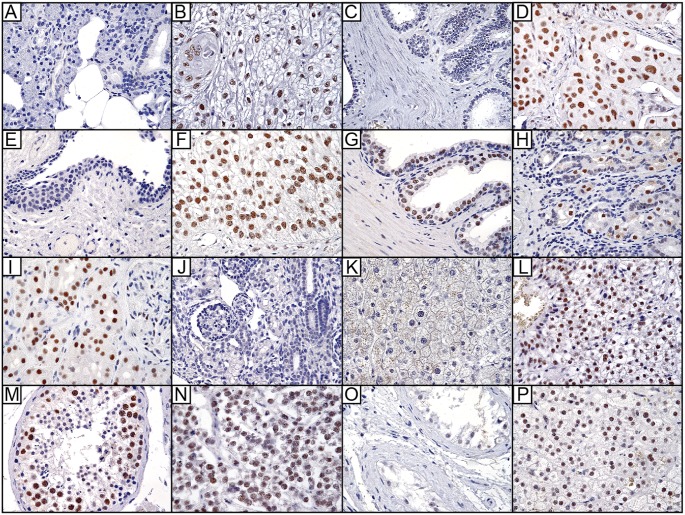
Representative images of MSANTD3 immunostaining in select tissues.(A) Normal salivary tissue, (B) Mucoepidermoid carcinoma, (C) Normal breast tissue, (D) Invasive breast carcinoma, not otherwise specified, (E) Normal bladder, (F) Urothelial carcinoma, (G) Normal prostate, (H) Normal stomach, (I) Normal kidney, (J) Fetal kidney, (K) Normal liver, (L) Hepatocellular carcinoma, (M) Normal testicle, (N) Seminoma, (O) Testicular atrophy, and (P) Adrenal cortex. Images were acquired at 40x magnification.